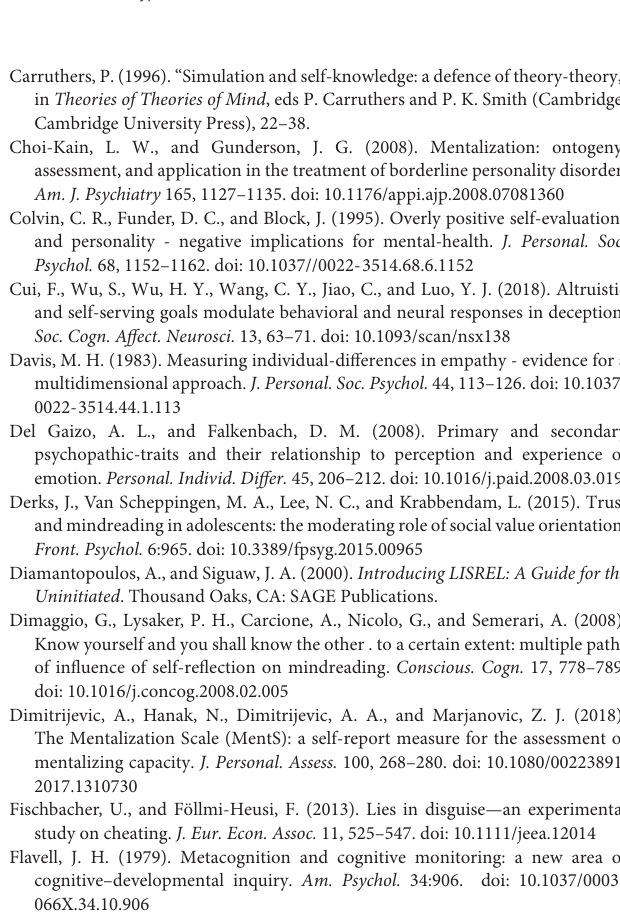
Supplementary Table S1 | The full items of the original items. Supplementary Figure S1 | The screen plot of the PCA components in sample 1. Supplementary Figure S2 | The parallel analysis scree plots in sample 1. Supplementary Figure S3 | The prediction effect of interaction between offer response and meta-mentalization in sample 3. Supplementary Figure S4 | The prediction effect of interaction between confidence and meta-mentalization on happiness of the results. Supplementary Figure S5 | The distributions of three sub scales in sample 1, sample 2, sample 3, and sample 4, the Shapiro–Wilk normality test cannot reject the non-normal hypothesis for all